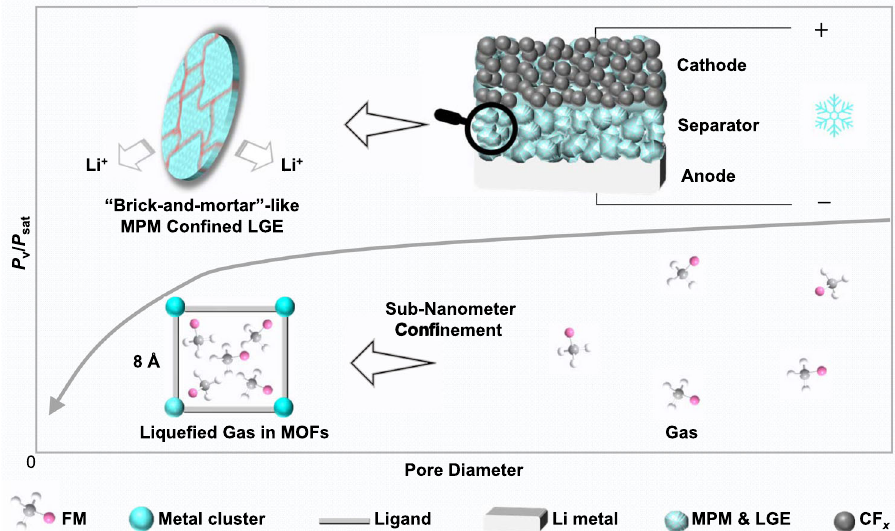
Fig. 1 Schematic showing the mechanism of nano-con fi nement effects for lowering the equilibrium pressure of lique fi ed gas and the implementation of MPM-based LGE for Li-battery cells. The cells were assembled by using LGE soaked MPM as the separator membrane, in which MOFs were employed as the porous hosts to condense the gas molecules under a lower P v than P sat , attributed to the driving force of the sub-nanometer con fi nement of MOFs 61